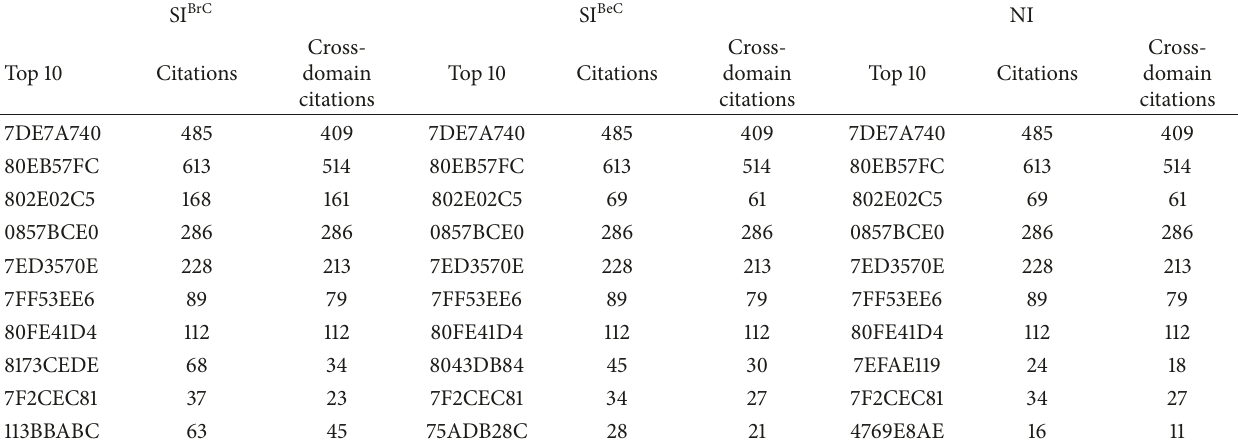
Table 2: Top 10 scholars of each